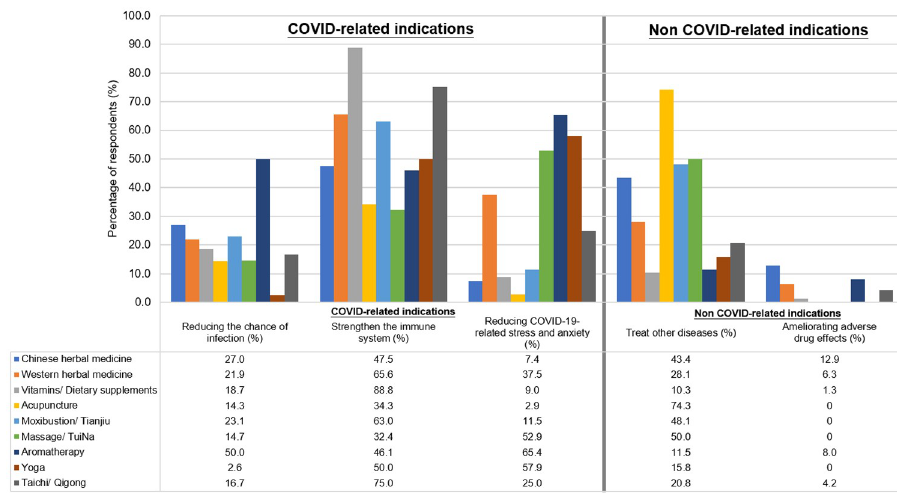
Fig 1. Reported indications for use of TCIM during COVID-19. TCIM, Traditional, Complementary and Integrative Medicine.